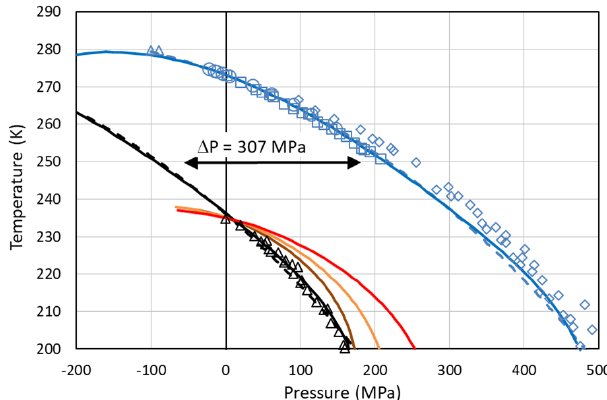
Figure 4. Pressure dependence of melting (blue) and freezing (black) temperatures of ice I . Melting point measurements of ice I are from Kanno et al. (1975) (blue squares), Mishima (1996) (blue diamonds), Henderson and Speedy (1987) (blue circles), and Roed- der (1967) (blue triangles). For simplicity, melting data of other ice polymorphs are not shown. The blue solid line is the melting curve calculated by setting Eq. (24) to zero. The dashed blue line is a fit to the measured melting temperatures (blue symbols) using the equa- tion given in Marcolli (2017b): T (K) = 557 . 2 − 273exp (( 300 + P (MPa)) 2 / 2270000). Freezing temperatures of ice I (black tri- angles) are from Kanno et al. (1975). The black solid and dashed lines represent a homogeneous ice nucleation rate of 10 8 cm − 3 s − 1 obtained by shifting the blue curves by (cid:49)P = 307MPa to lower values. Red line: Ick15 parameterization with pressure-dependent chemical potential ( (cid:49)µ iw of Eq. 24); all other parameters without pressure dependence. Orange and brown lines: Mr10 parameteriza- tion with pressure-dependent chemical potential ( (cid:49)µ iw of Eq. 24) with n = 0 . 3 (brown) and n = 0 . 97 (orange); all other parameters without pressure dependence. Fully pressure-dependent Ick15 and Mr10 parameterizations were optimized to overlay with the experi- mental freezing data and are not shown